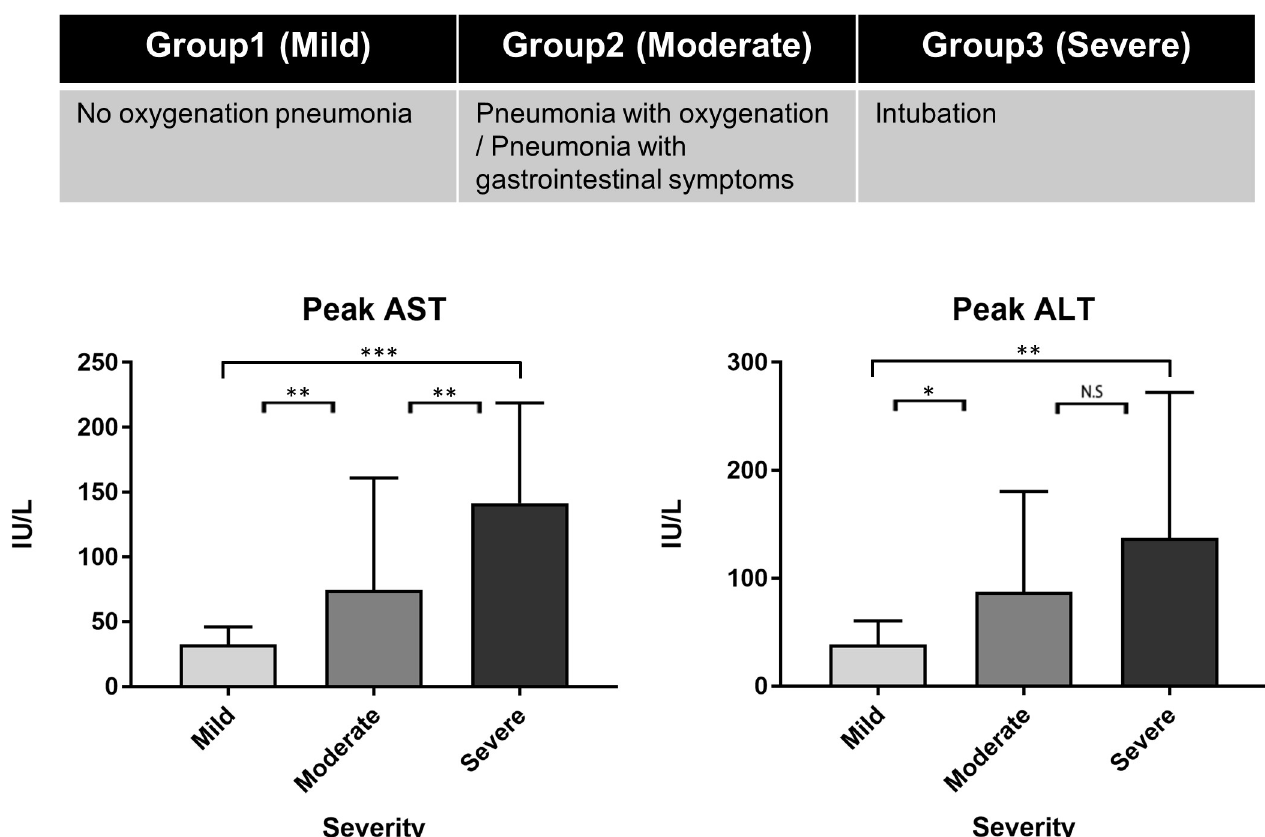
Fig 3. The peak of liver enzymes of patients with COVID-19 with a new severity classification for liver injury.